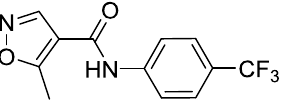
Figure 1. Leflunomide (Avara).